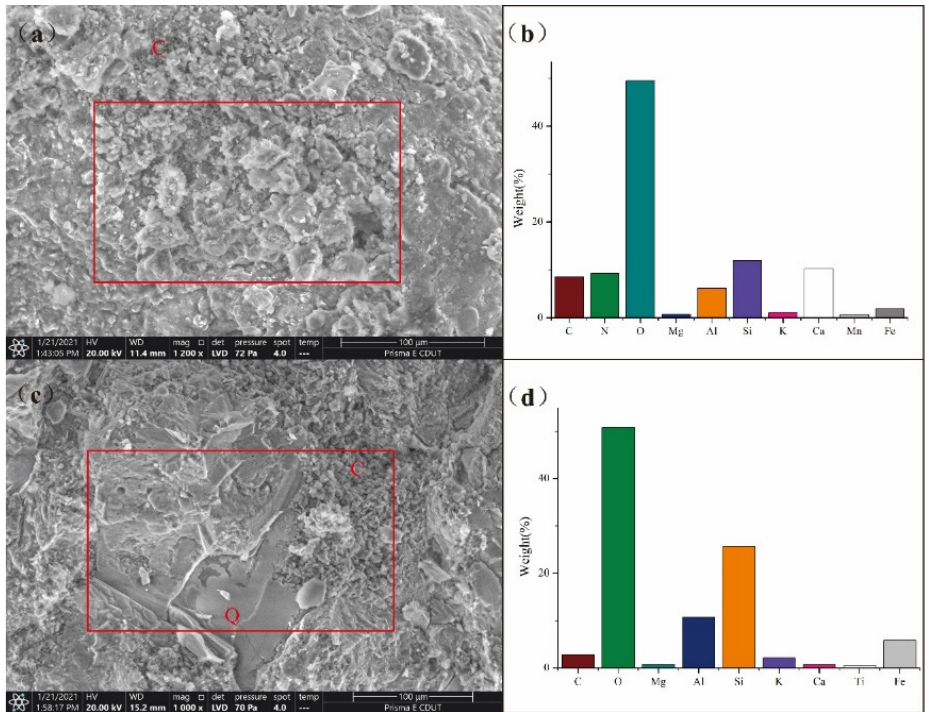
Figure 4. SEM images of the soil ( a ) and tailing ( c ), corresponding EDS spectrum ( b , d ). The red box indicates the scope of EDS analysis. Q—quartz; C—clay.